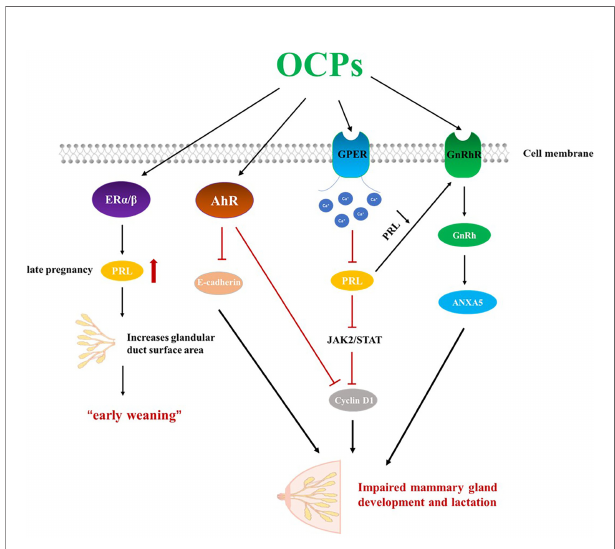
FIGURE 2 | OCPs can act as estrogen endocrine disruptors and impair lactation. OCPs, organochlorine pesticides; ER a , estrogen receptors a ; ER b , estrogen receptors b ; GPER, G-protein coupled estrogen receptor; AhR, aryl hydrocarbon receptor; GnRhR, Gonadotropin-releasing hormone receptor; GnRh, Gonadotropin-releasing hormone; PRL,